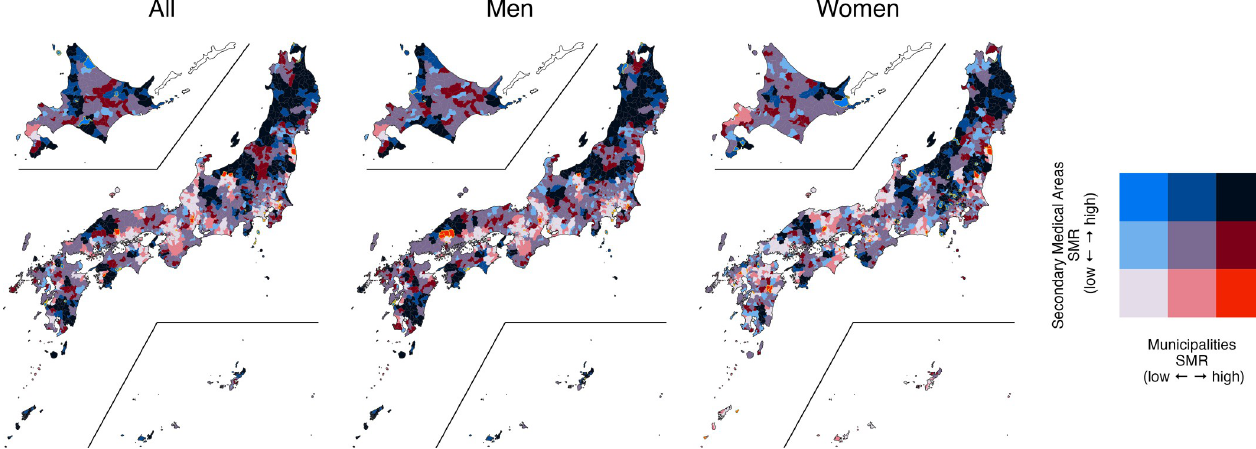
Fig 5. Bivariate map between municipalities and secondary medical areas. SMR: standardized mortality ratio; geographic distribution was visualized based on the tertiles of each region. The following map data (CC BY 4.0) was processed and used: Ministry of Land, Infrastructure, Transport and Tourism. National surveys of Japan—Administrative area data (in Japanese). 2019. Available from: https://nlftp.mlit.go.jp/ksj/gml/datalist/KsjTmplt-N03-v3_0.html.